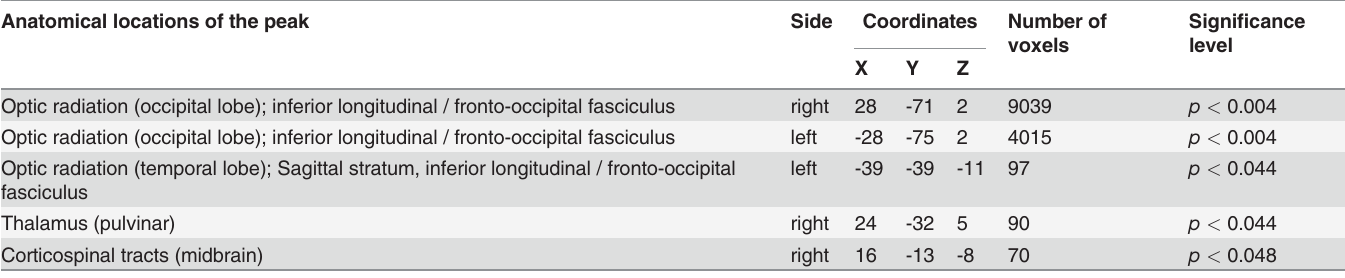
Table 2. Peak coordinates (MNI), cluster extent, and anatomical regions of the contrast “ sighted > late-blind ” (two sample t -test). Anatomical locations of the peak Side Coordinates